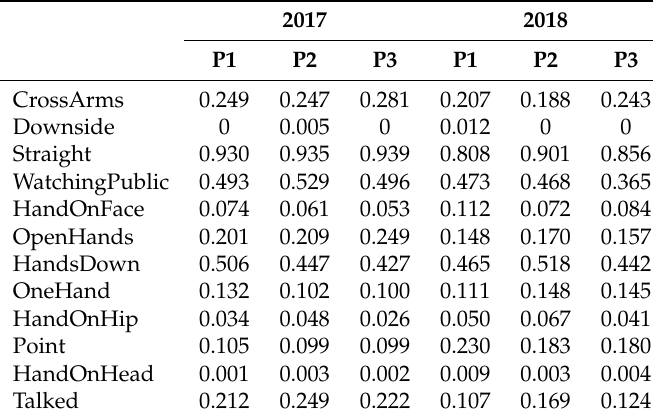
Table 3. Average values of each attribute.